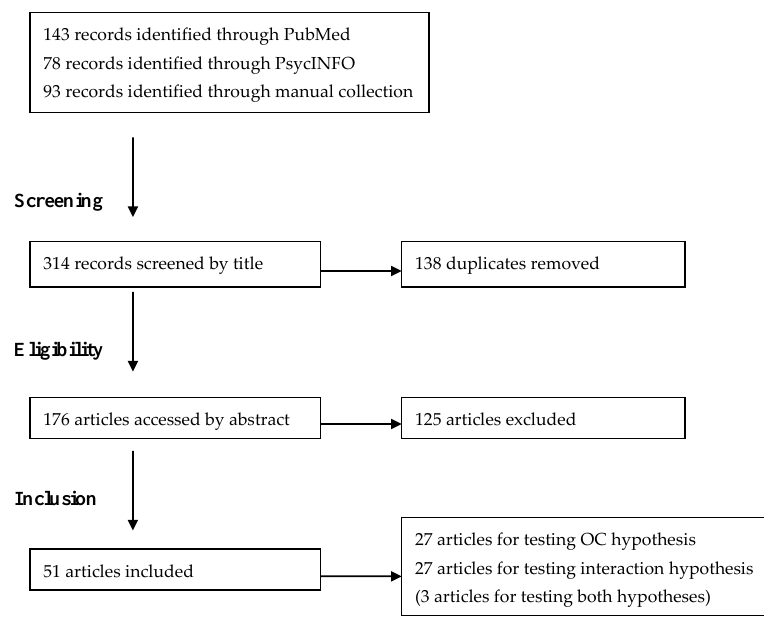
Figure 1. Flowchart of included and excluded articles.